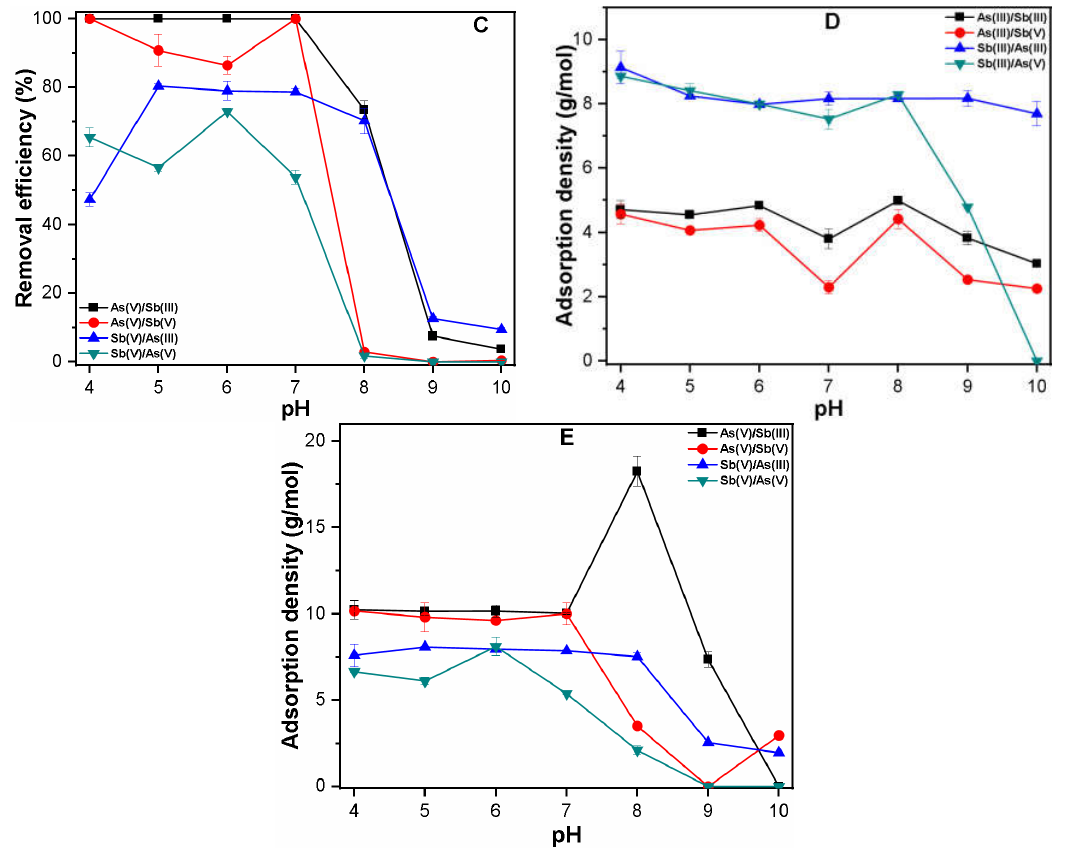
Figure 2. Binary system of As and Sb species showing ( A ) Fe solubility (%); ( B , C ) Removal efficiency (%); ( D , E ) Adsorption densities (g/mol) under various pH range (4–10) with 0.1 mM FC coagulant dose.